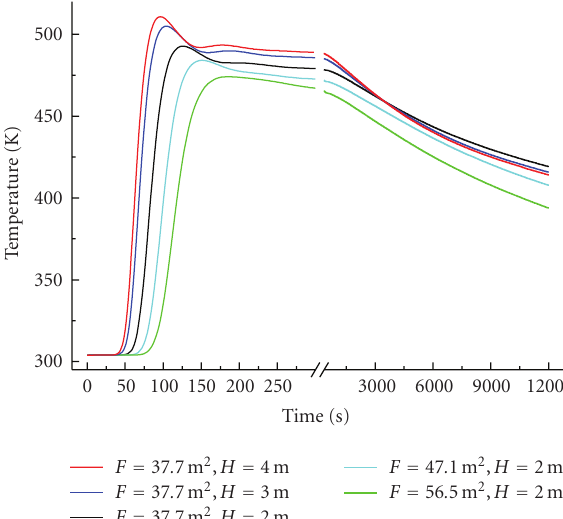
Figure 8: Mass flow rates of the third loop with di ff erent height di ff erences and heat transfer areas.